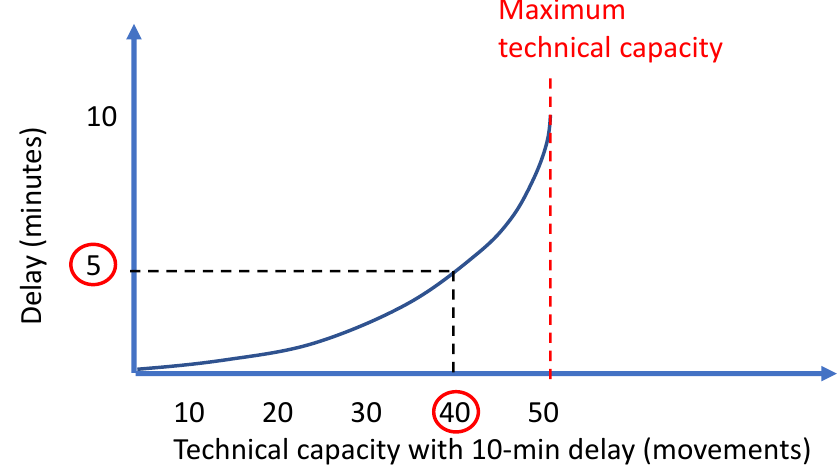
Figure 1. Example of the technical capacity curve for a 10-min delay threshold .